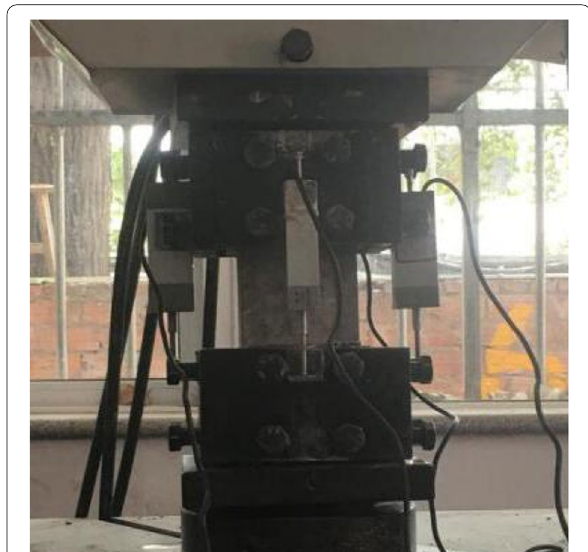
Fig.2 Loading-schematic